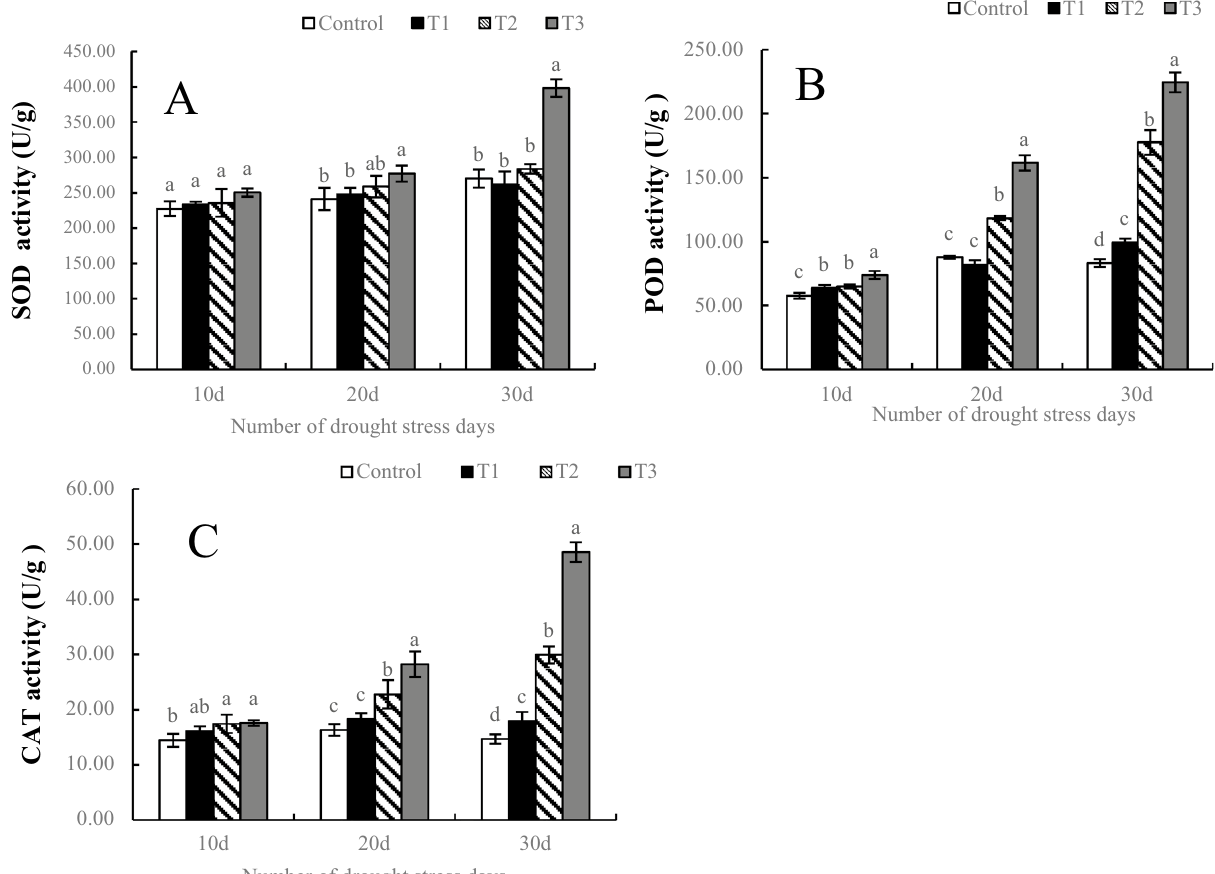
Figure 5. Effects of drought stress on the antioxidant enzyme activities in Phedimus aizoon L. Notes : SOD activity ( A ), POD activity ( B ), CAT activity ( C